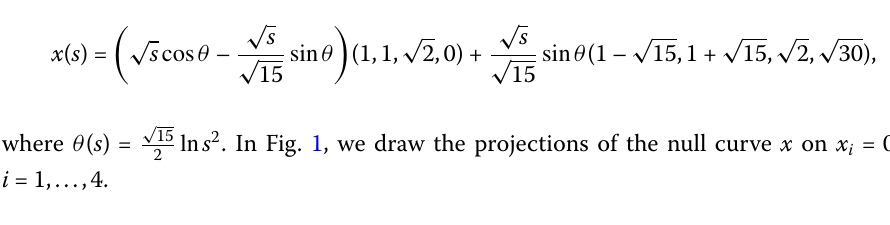
sinh s ,11cosh s + 25 3